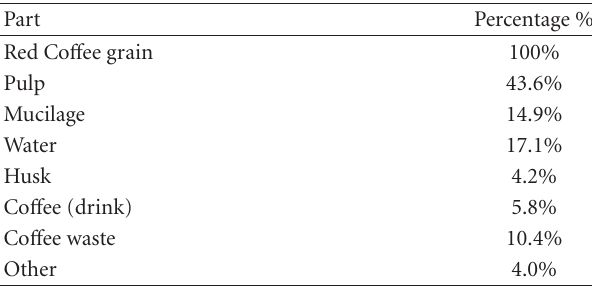
Table 1: Mass balance of products obtained from co ff ee grain pre-